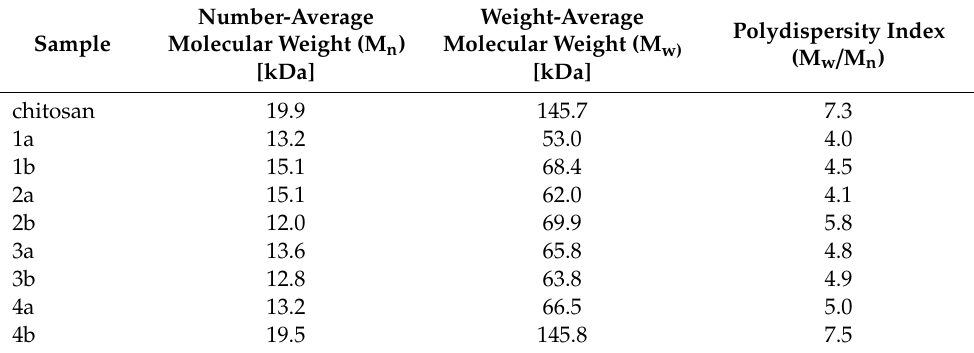
Table 1. Molecular weights and polydispersity index for chitosan and chitosan